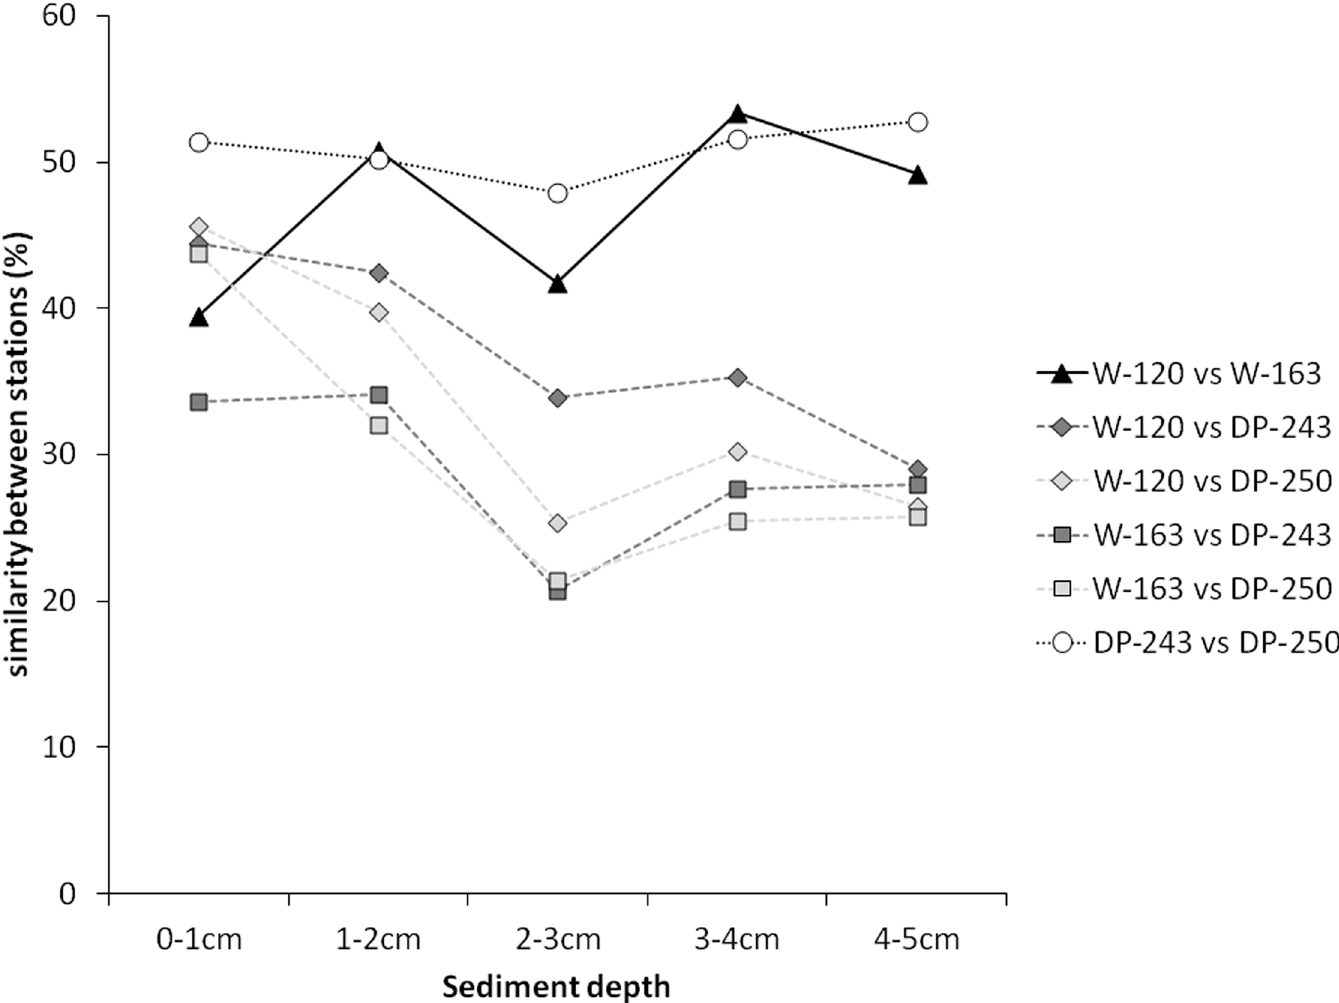
Fig 4. Visualisation of pairwise comparisons of the PERMANOVA interaction ‘ station × layer ’ . Graph plots similarities of nematode assemblages between the different stations according to depth in the sediment.